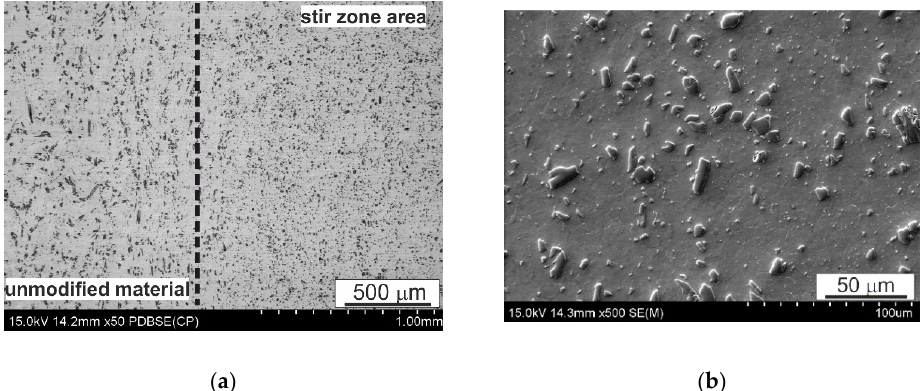
Figure 6. Microstructure of SnSb9Cu4 alloy after FSP; 560 RPM; ( a ) figure show both the zone after pin passage and the area without modification, ( b ) figure show stir zone area.